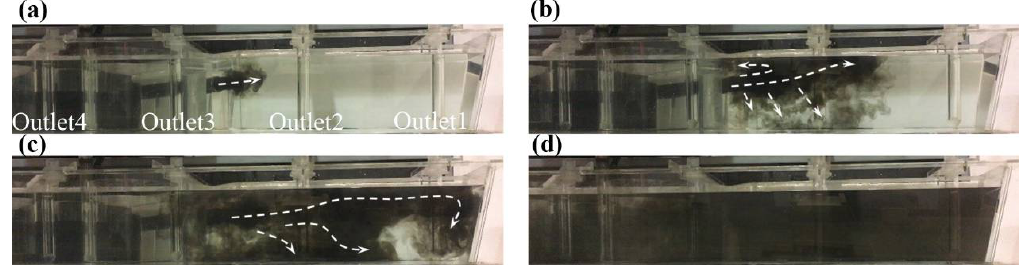
Figure 12. Ink dispersion behavior in case C1: ( a ) 25 s, ( b ) 49 s, ( c ) 106 s, ( d ) 321 s.